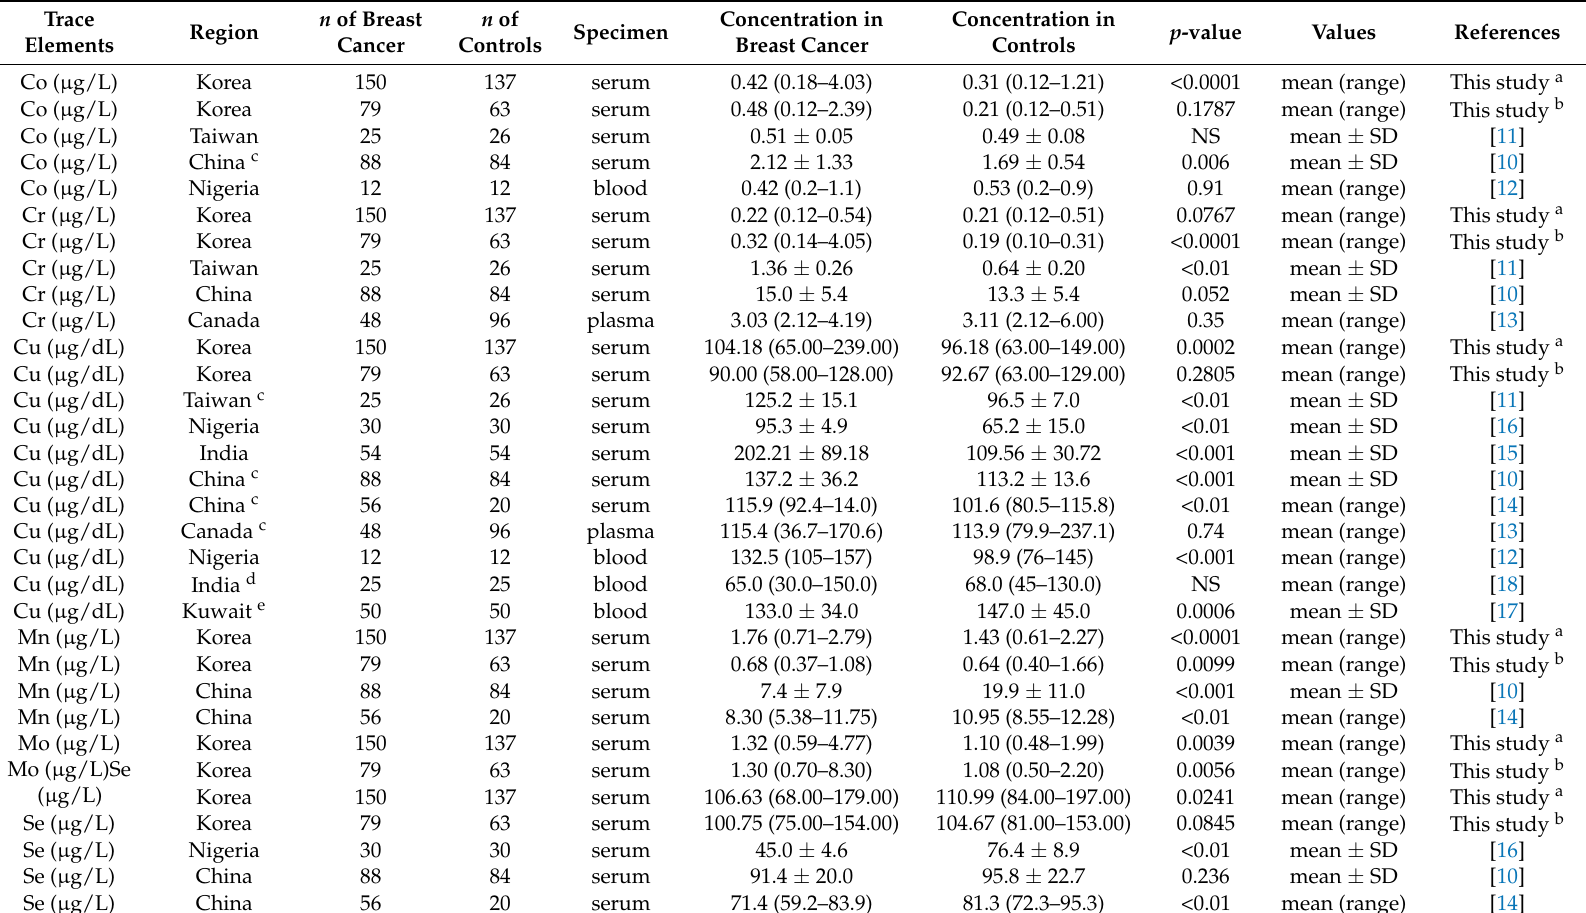
Table 4. Previous studies of trace element concentrations in breast cancer patients compared with